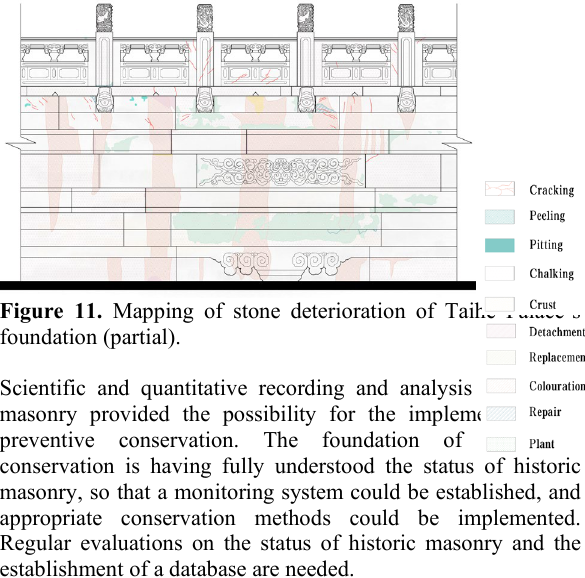
Figure 11. Mapping of stone deterioration of Taihe Palace’s foundation